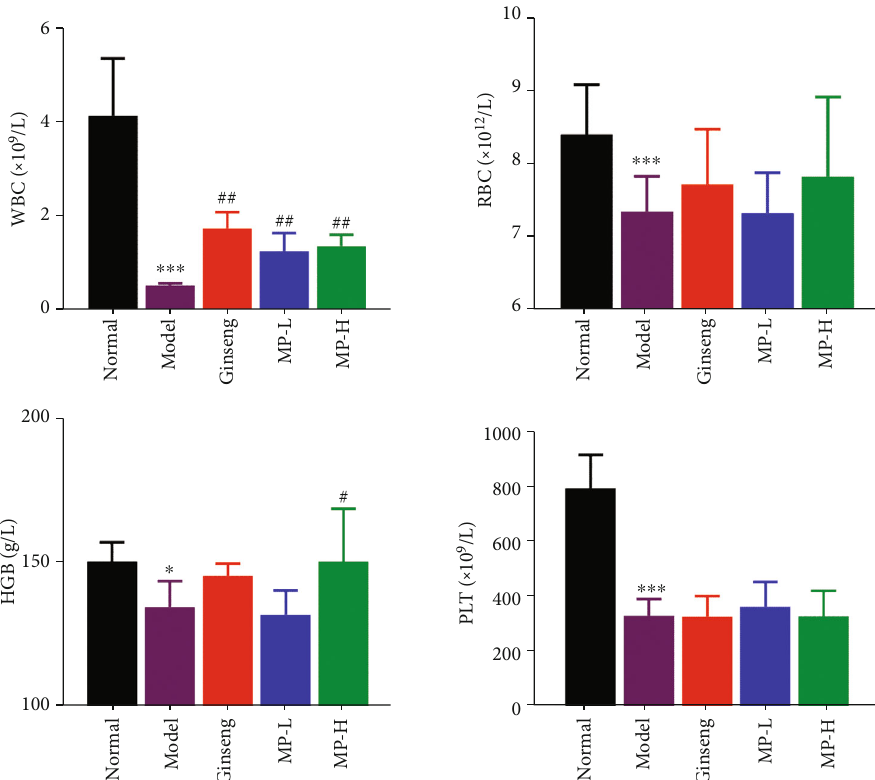
Figure 4: E ff ects of Maca polysaccharides on haematological parameters ( n = 12 ); ∗ p < 0 : 05 and ∗∗∗ p < 0 : 001 vs. control group; # p < 0 : 05 and ## p < 0 : 01 vs. model